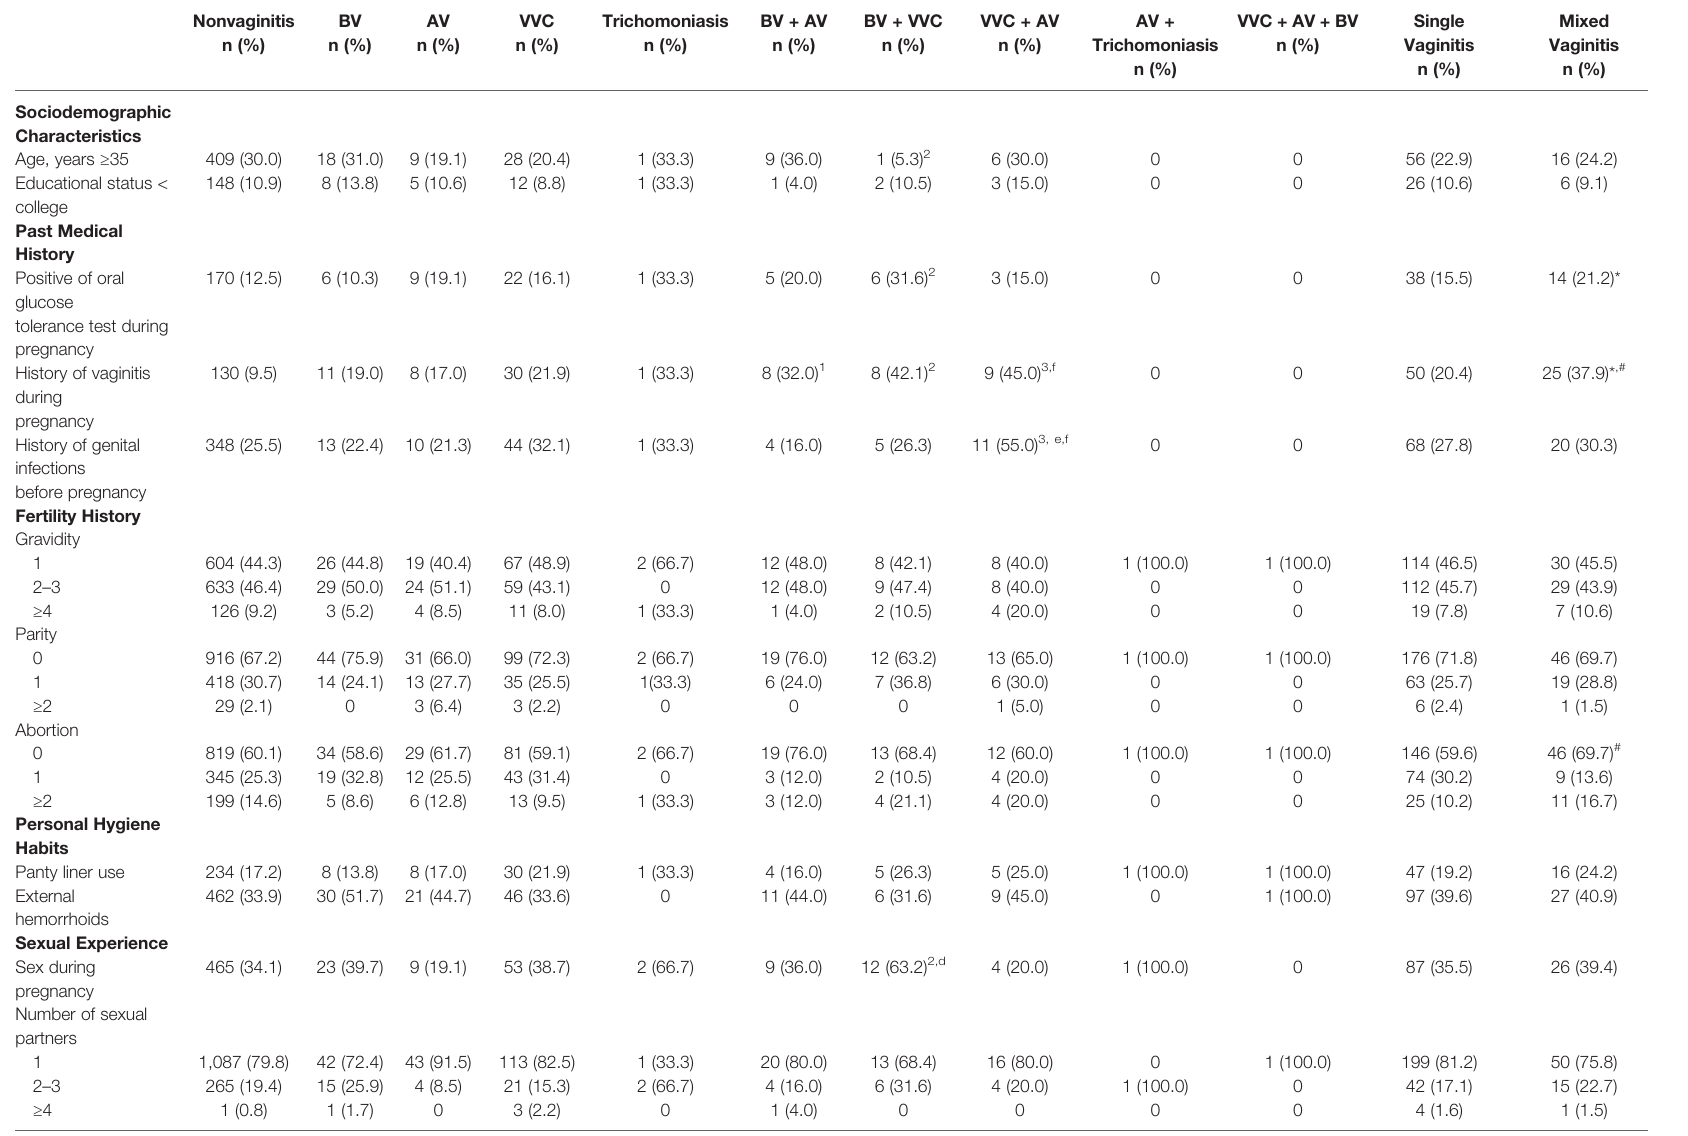
TABLE 2 | Clinical characteristics, vaginal microecological characteristics, symptoms and signs, and maternal – neonatal outcomes of women with mixed vaginitis during late